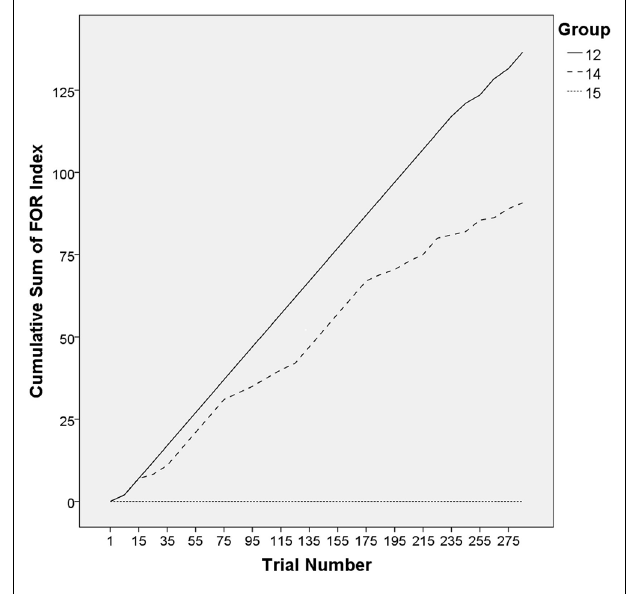
FIGURE 6 | Exemplary time course of difference scores for three groups.